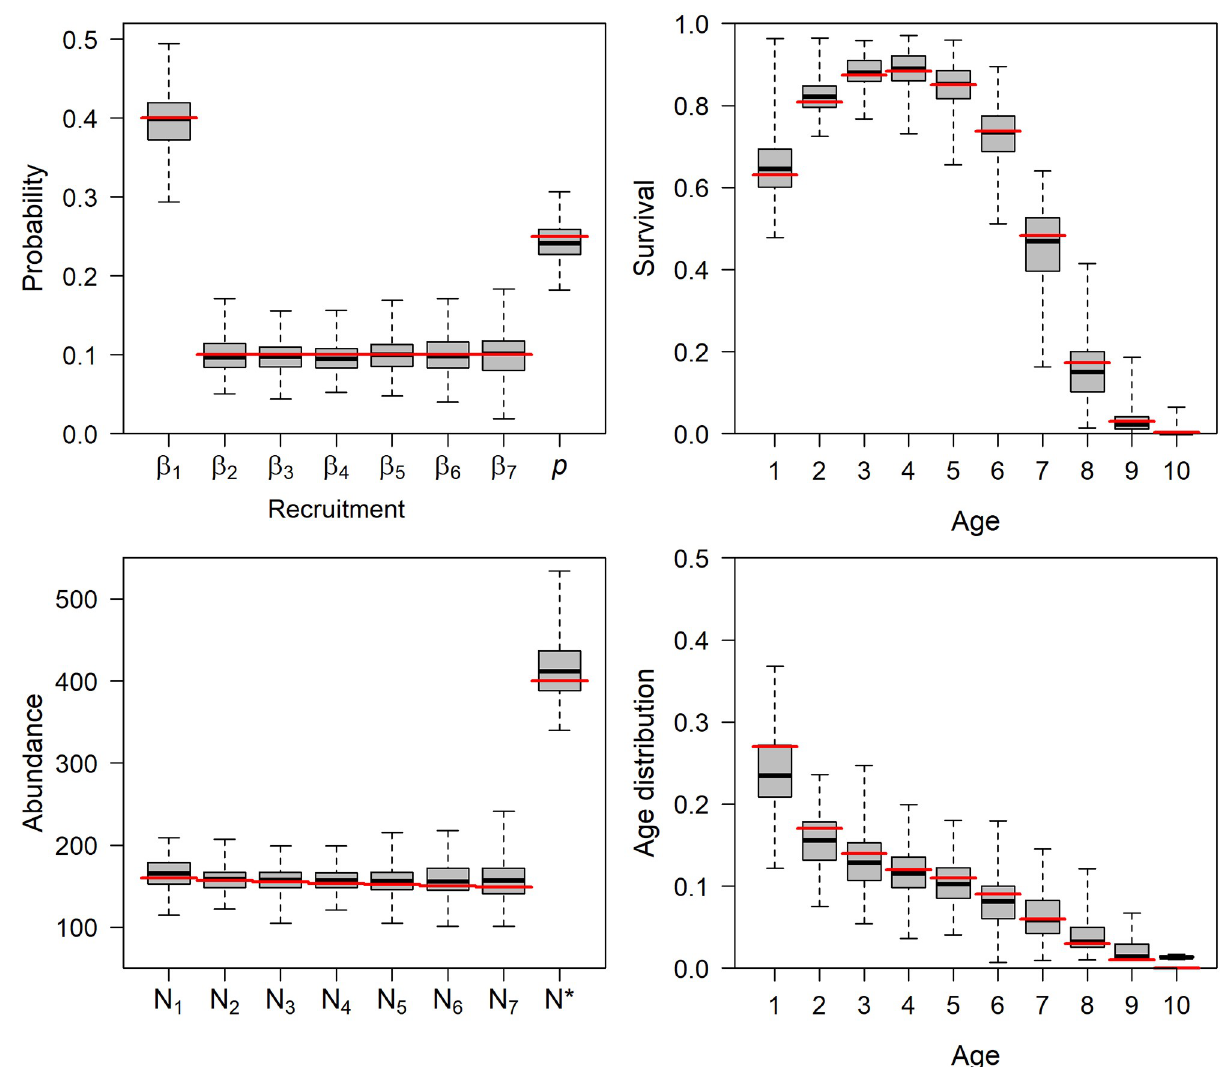
Fig 2. Boxplots of posterior medians for annual recruitment and detection ( β and p , respectively; top left), age-specific survival (top right), k abundances (bottom left), and initial age distribution (bottom right) from 200 simulated data sets analyzed using age-structured Jolly-Seber models where survival is a quadratic function of age. Boxplots include medians (black line), interquartile range (box), and range of values (whiskers). Red horizontal lines denote data generating values. Data generation fixed the maximum age in year 1 ( J ) at 9, but analyses assumed J = 10 to evaluate robustness to uncertainty in maximum